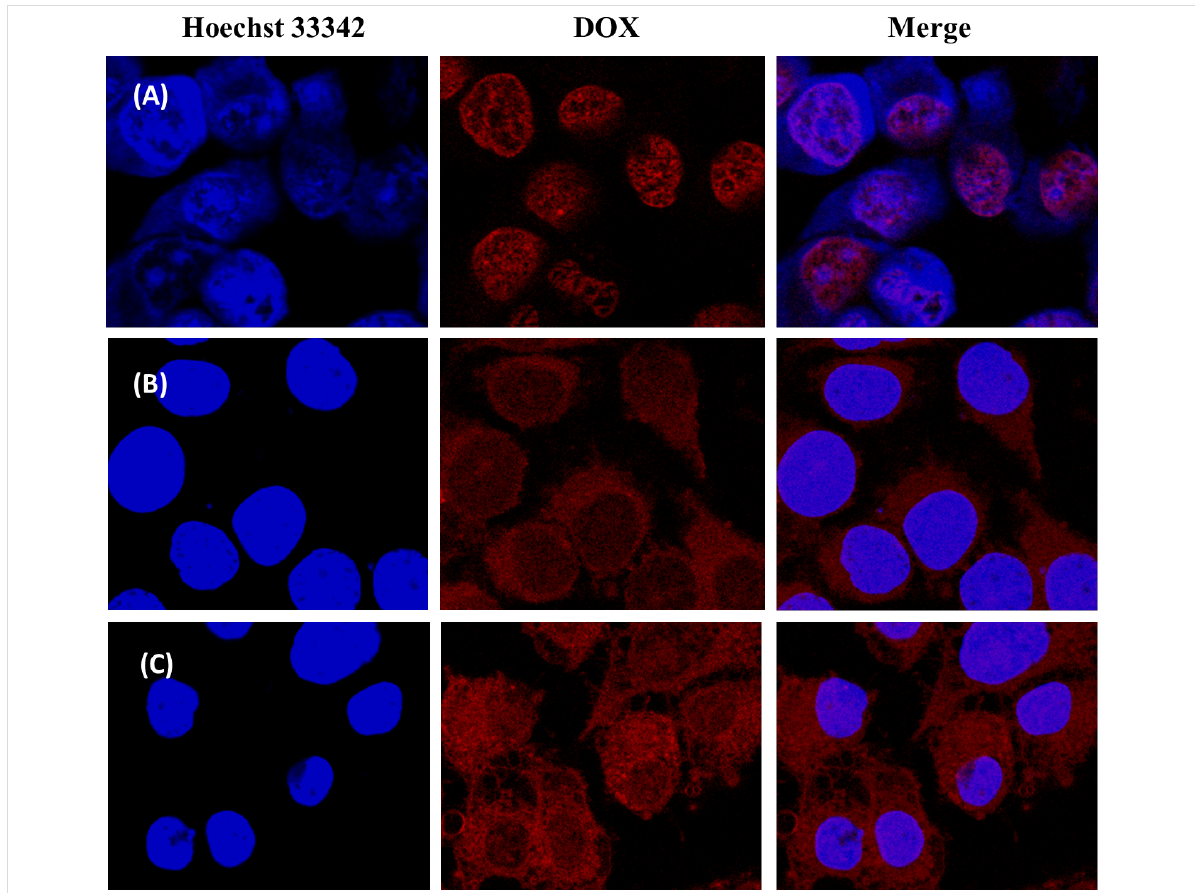
Figure 6: CLSM images of PC-3 cells incubated with the FSSAs and free DOX·HCl at a concentration of 5 μ g/mL. From left to right: Hoechst 33342 (blue), DOX (red) and a merge of two images. (A) Free DOX·HCl, 4 h; (B) FSSAs, 1 h; (C) FSSAs, 4